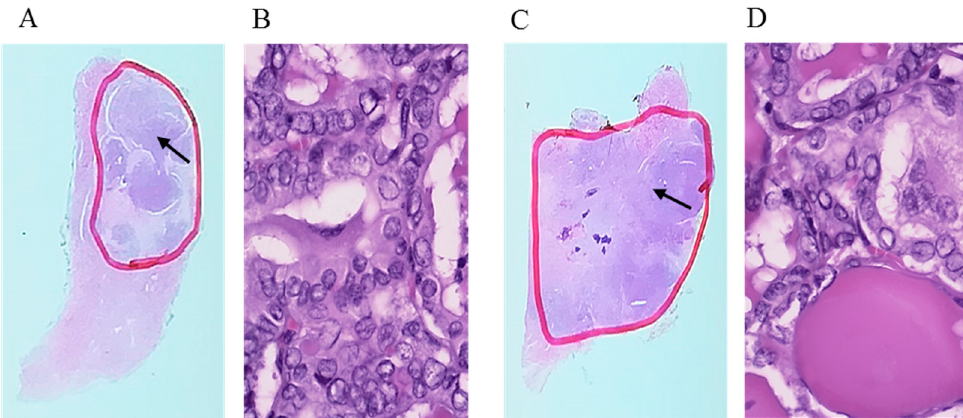
Figure 1. Representative cancer foci images. Hematoxylin and eosin staining of 2 different papillary thyroid carcinoma (PTC) samples-the primary tumour foci have been marked by pathologist (red line) ( A ) and ( C ). The images ( B ) and ( D ) show magnification ×400.